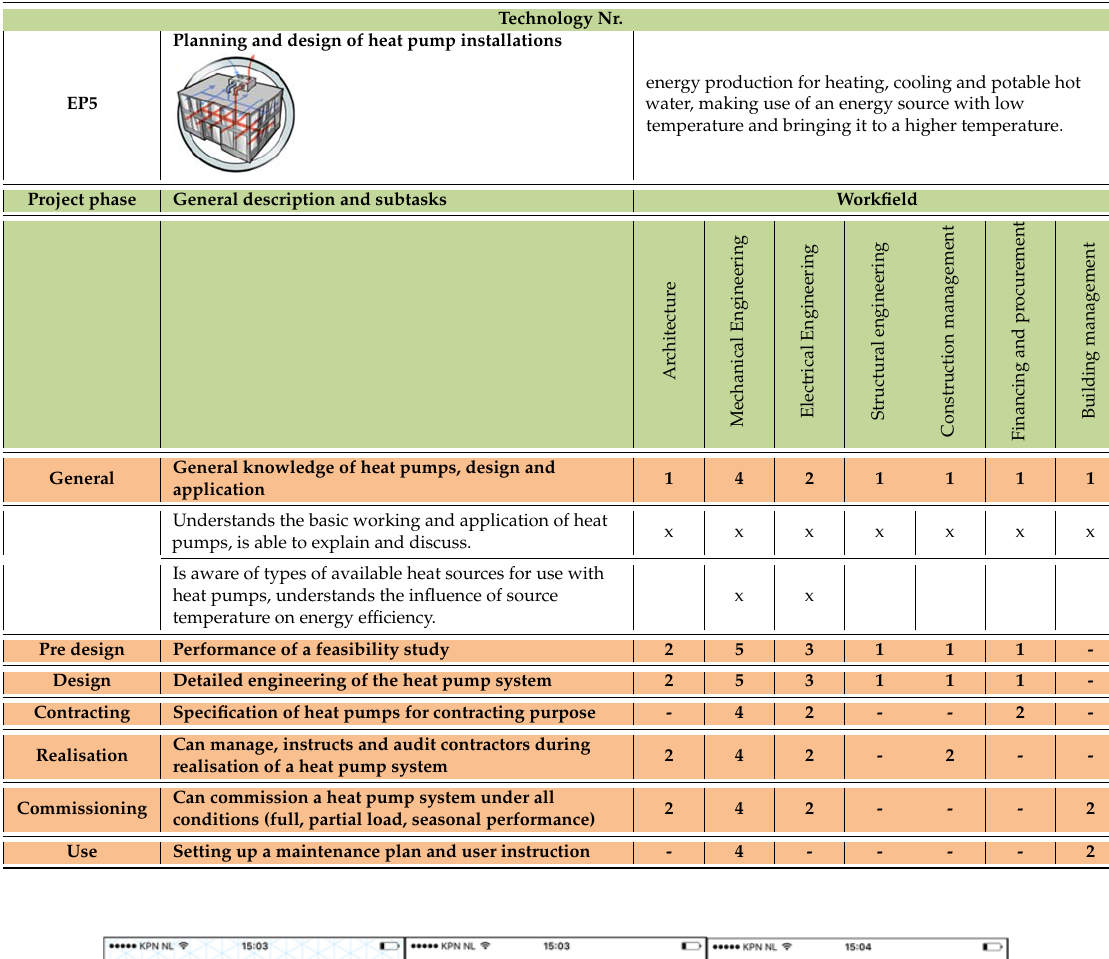
Table 3. PROF/TRAC Qualification Framework for the heat pump technology. Technology Nr.